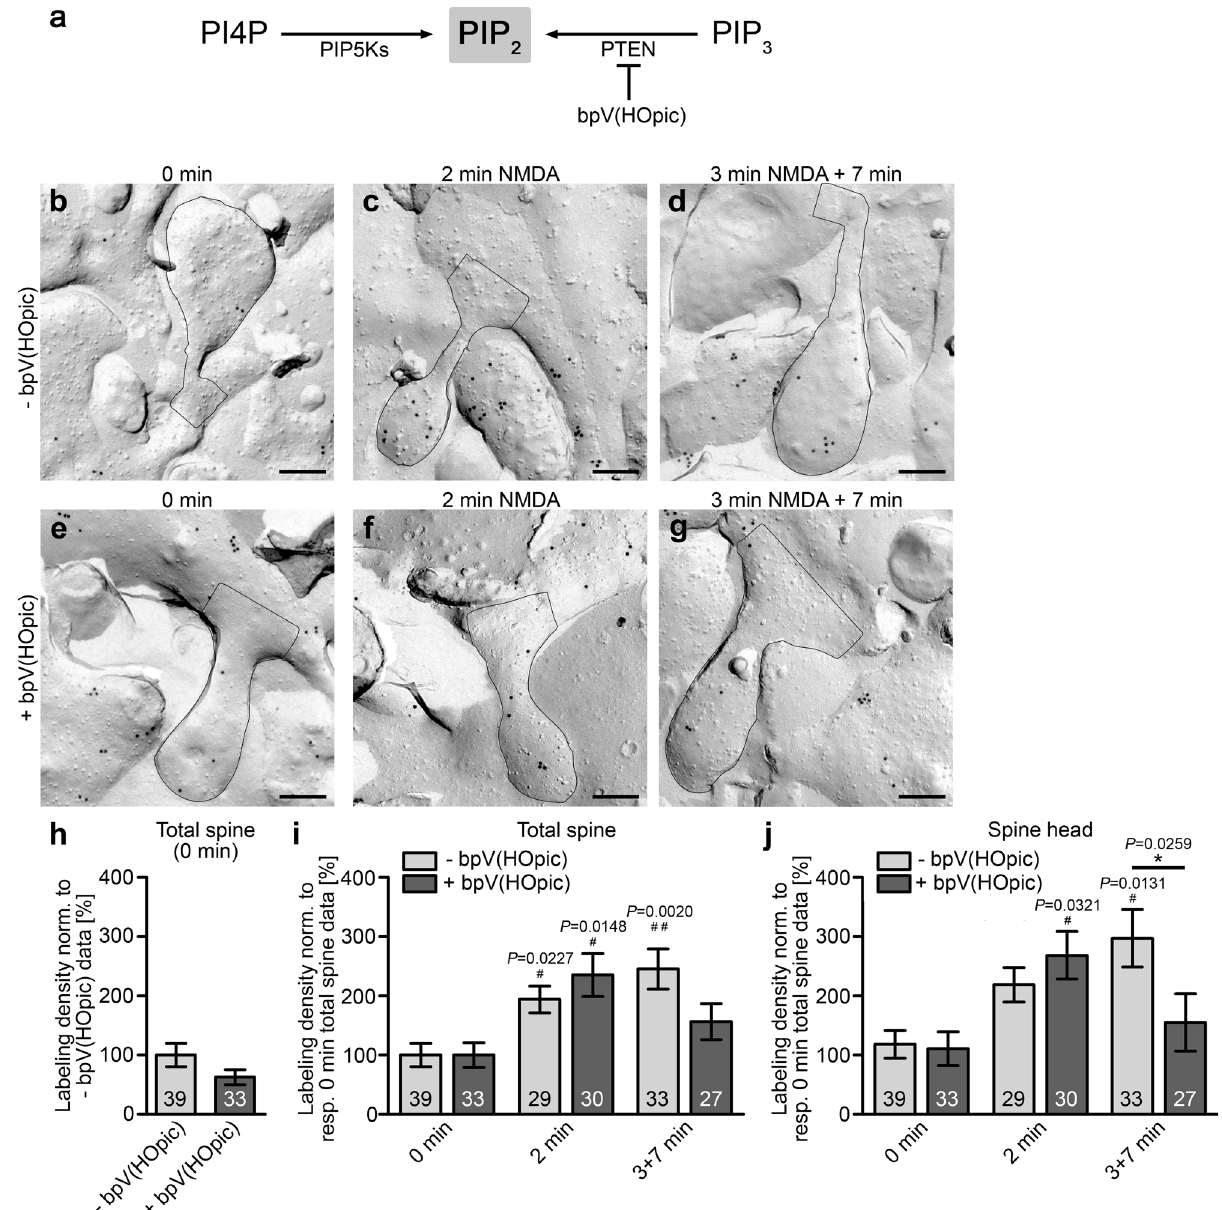
Fig. 6 The second phase of LTD-associated PIP2 dynamics is dependent on PTEN in the spine head whereas the early phase of LTD induction is not. a Scheme visualizing suggested routes towards PIP 2 during LTD and the inhibition by bpV(HOpic). b – g Representative TEM images of cryo-preserved, freeze-fractured and anti-PIP 2 immunogold-labeled spines of DIV14-16 hippocampal neurons pretreated for 60 min with ddH 2 O as a vehicle control ( b – d ) or with 15 nM bpV(HOpic) ( e – g ) and subjected to NMDA-induced LTD for 2 min ( c , f ) and for 3 min NMDA followed by 7 min postincubation time ( d , g ) in comparison to non-NMDA-treated controls (0 min) ( b , e ). Bars, 200 nm. h Quantitative analyses of the anti-PIP 2 labeling density in neurons pretreated with bpV(HOpic) compared to the merely ddH 2 O-treated neurons ( − bpV(HOpic)) in the same assays not revealing any statistically signi fi cant effect of PTEN inhibition on basal PIP 2 levels. The labeling densities were normalized to the respective - bpV(HOpic) control. i , j Quantitative analyses of PIP 2 signaling during the fi rst and second phase of LTD induction in the total spine ( i ) and in the spine head ( j ), respectively, (both normalized to the respective 0 min data for the total spine labeling densities of each of the two conditions, i.e., with and without inhibitor). Data, mean ± SEM. − bpV(HOpic), 0 min, n = 39; 2 min, n = 29; 10 (3 + 7) min, n = 33 ROIs each (total spines; spine heads) and + bpV(HOpic), 0 min, n = 33; 2 min, n = 30; 10 (3 + 7) min, n = 27 ROIs each (total spines; spine heads) of primary neurons from 3 independent assays. Mann – Whitney ( h ); Two-way ANOVA/Bonferroni ’ s Multiple Comparison between ±bpV(HOpic) conditions ( i , j ). *P < 0.05. Additional Kruskal – Wallis/Dunn ’ s Multiple Comparisons were conducted for comparison of + and − bpV(HOpic) data at 2 min and at 3 + 7 min to 0 min control data ( i , j ) # P < 0.05; ## P < 0.01. P -values are reported directly in the fi gure. For numerical source data, see Supplementary Data